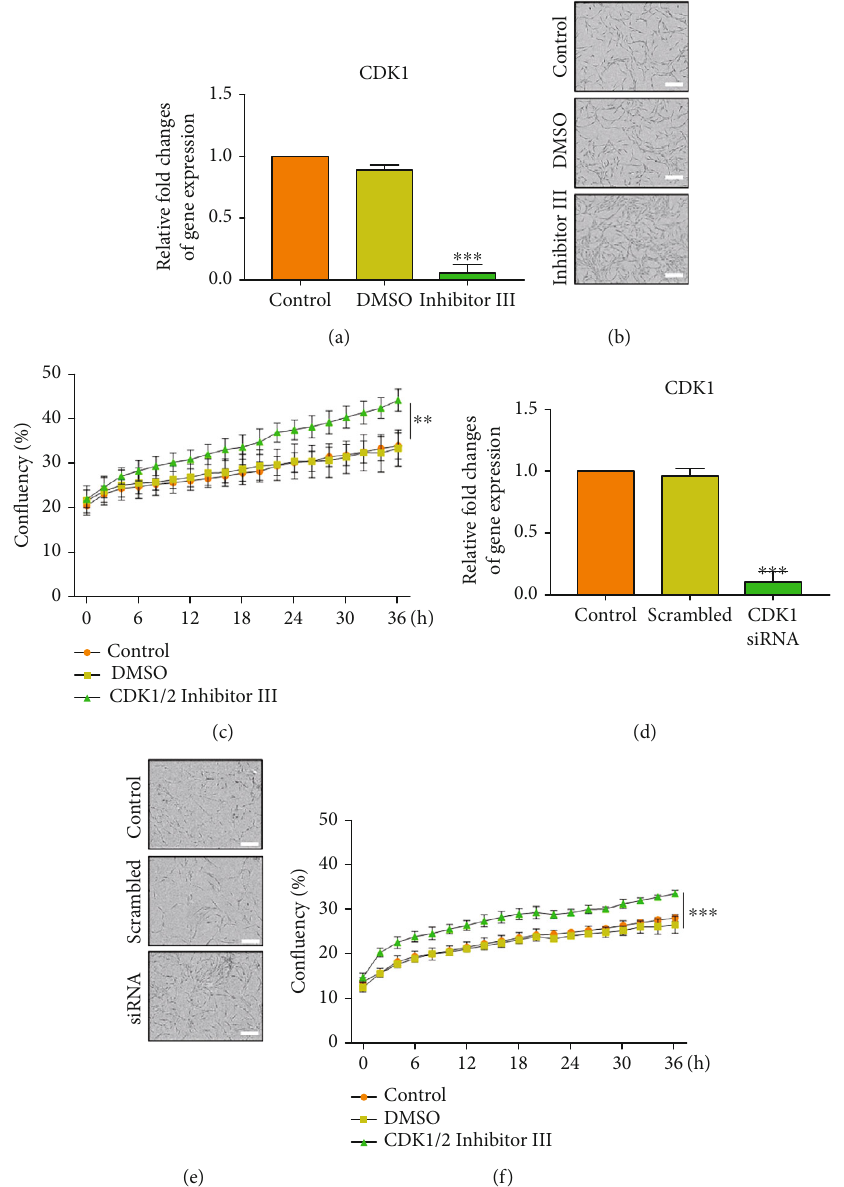
Figure 6: Con fi rmation of CDK1 function in TMSCs. The relative fold change bar graph of CDK1 gene expression with (a) CDK1/2 inhibitor III and (d) CDK1 siRNA. (b, e) Comparison of cell con fl uency for each group. Cell proliferation pro fi le of (c) old TMSCs vs. CDK1-inhibited TMSCs and (f) old TMSCs vs. old TMSCs transfected with CDK1 siRNA. The p values were considered statistically signi fi cant ( ∗∗∗ p < 0 : 001 ); scale bar, 200 μ